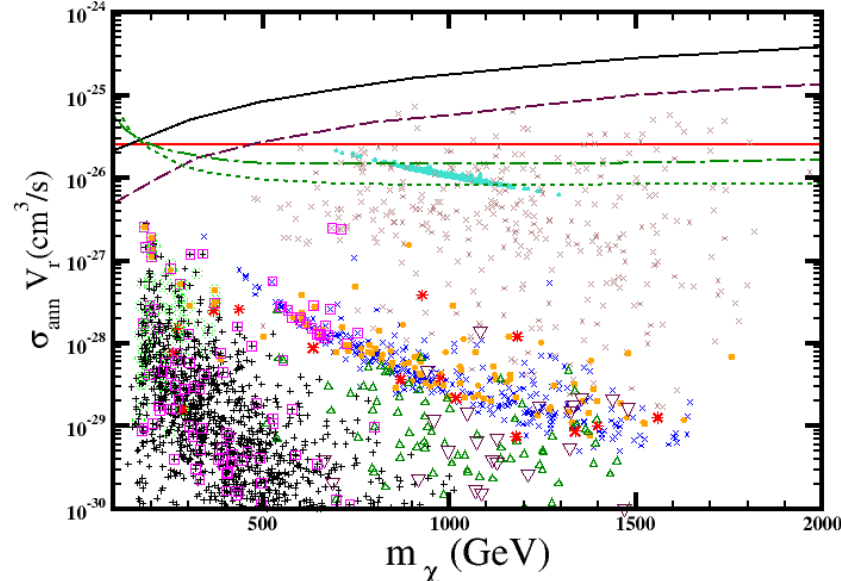
Figure 6 . Scatter plot for the total non-relativistic LSP annihilation cross section times rela- tive velocity as a function of the neutralino mass. The lines correspond to the current (solid black line) and projected (black dashed line) Fermi -LAT bounds from the search of DM in Dwarf spheroidal galaxies assuming (cid:22) bb (cid:12)nal states. The green lines correspond to expected CTA bound from observation of the Galactic halo, assuming (cid:22) bb (cid:12)nale states (dot-dashed line) or annihilation into W + W (cid:0) (cid:13) (dotted line). The horizontal red line corresponds to the usual benchmark value of h (cid:27) e(cid:11) v rel i ’ 2{3 (cid:2) 10 (cid:0) 26 cm 3